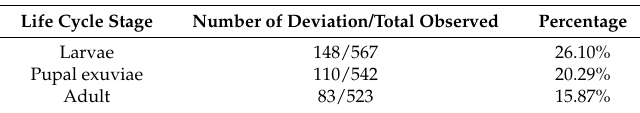
Table 4. Percentages of deviations from existing morphological discrimination characteristics (Suguna et al. [6]).